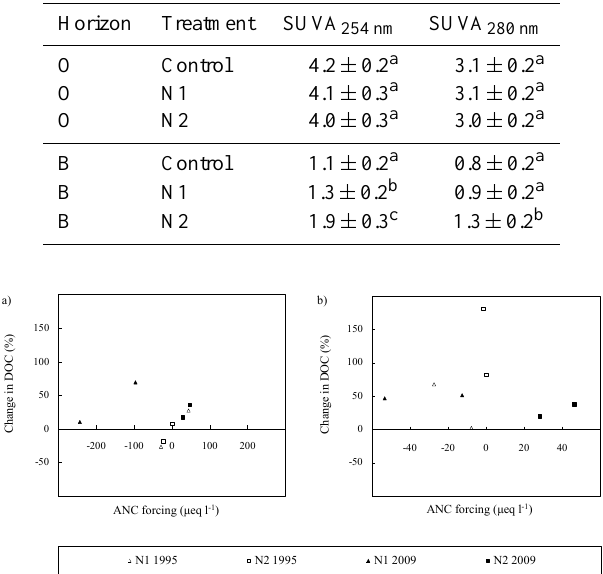
Table 6. Specific UV absorbance at 254 (SUVA 254 nm ) and 280nm (SUVA 280 nm ) at Str˚asan experimental forest in O horizon and B horizon leachates. Both SUVA 254 nm and SUVA280nm are in Lmg − 1 m − 1 . Values are mean ± 95% confidence intervals ( n = 24). Superscripts ( a , b and c ) denote significant differences at P = 0 . 05 (Tukey HSD test). Within column and soil horizon, means lacking a common superscript differ.